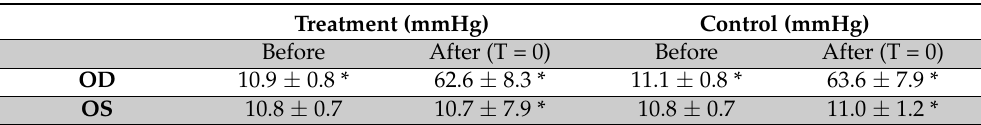
Table 1. IOP measurements (mmHg) for both eyes, before and after (T = 0) glaucoma induction, in treatment ( n = 12) and control groups ( n = 12). OD, right eye; OS, left eye. Treatment (mmHg) Control (mmHg) Before After (T = 0) Before After (T = 0)